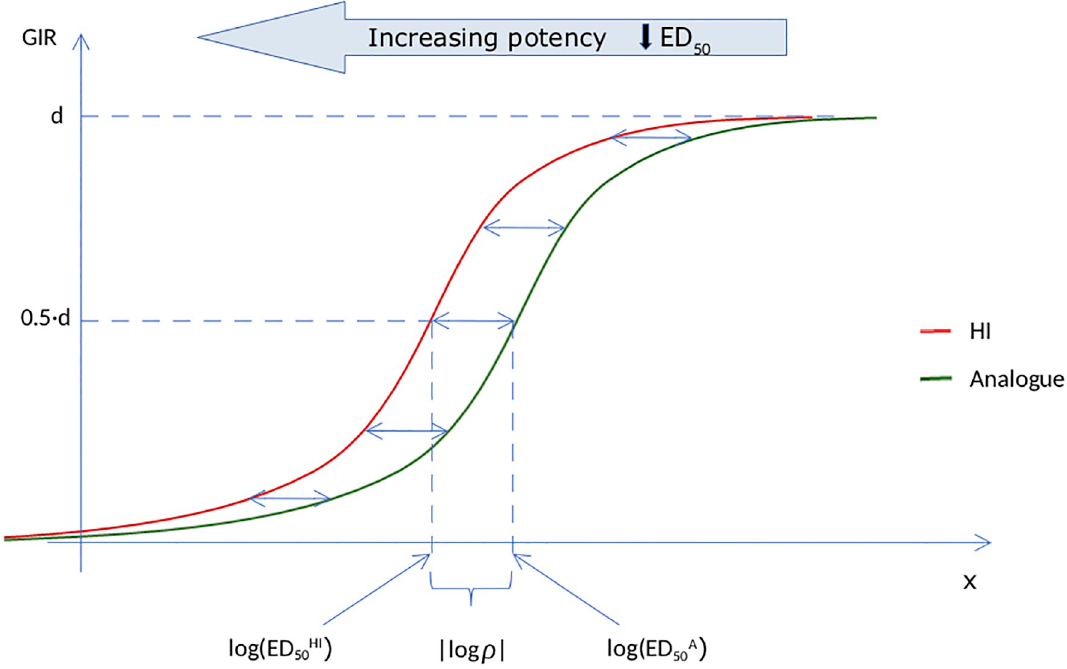
Fig 2. The logistic model, Eq (1), for the GIR as a function of the logdose of constant insulin infusion for HI and an insulin analogue. The two curves are parallel, and the relative log-potency, log ρ , is defined as the horizontal difference between the curves. The further the curve is to the left, the higher the